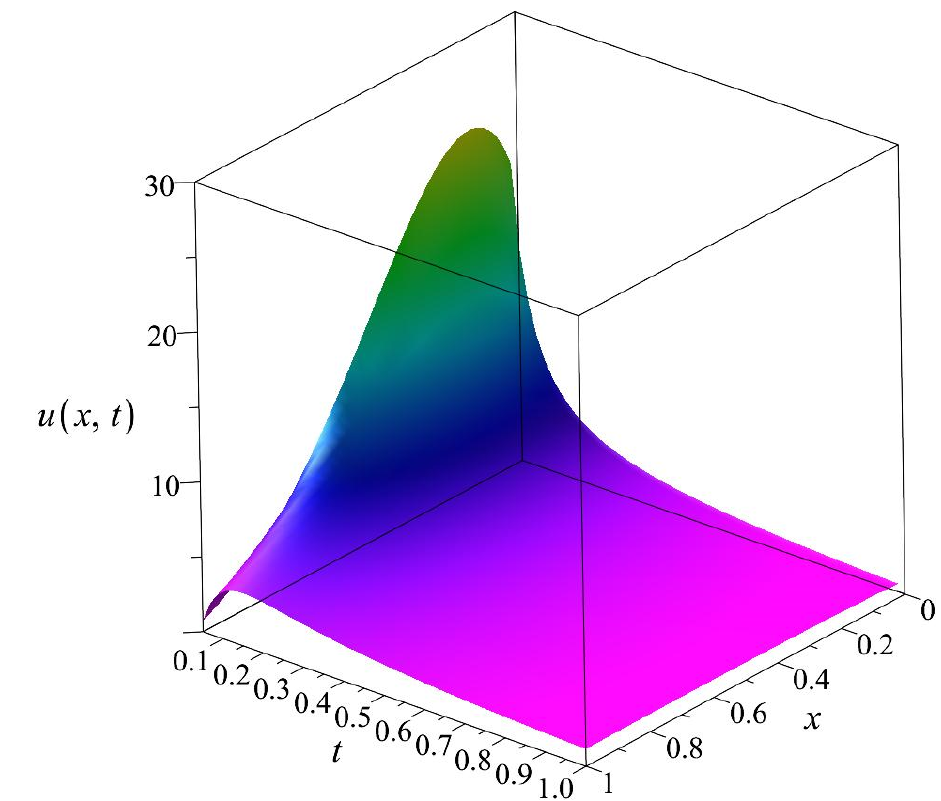
Figure 2. The solution of Equation (2). The presented u ( x, t ) function with the shape function of Equation (3) is for the α = 1, c 1 = 0, c 2 = 1, D = 2 and m = 1/3 parameter set. One can see that the solution decays more quickly in time than in space.